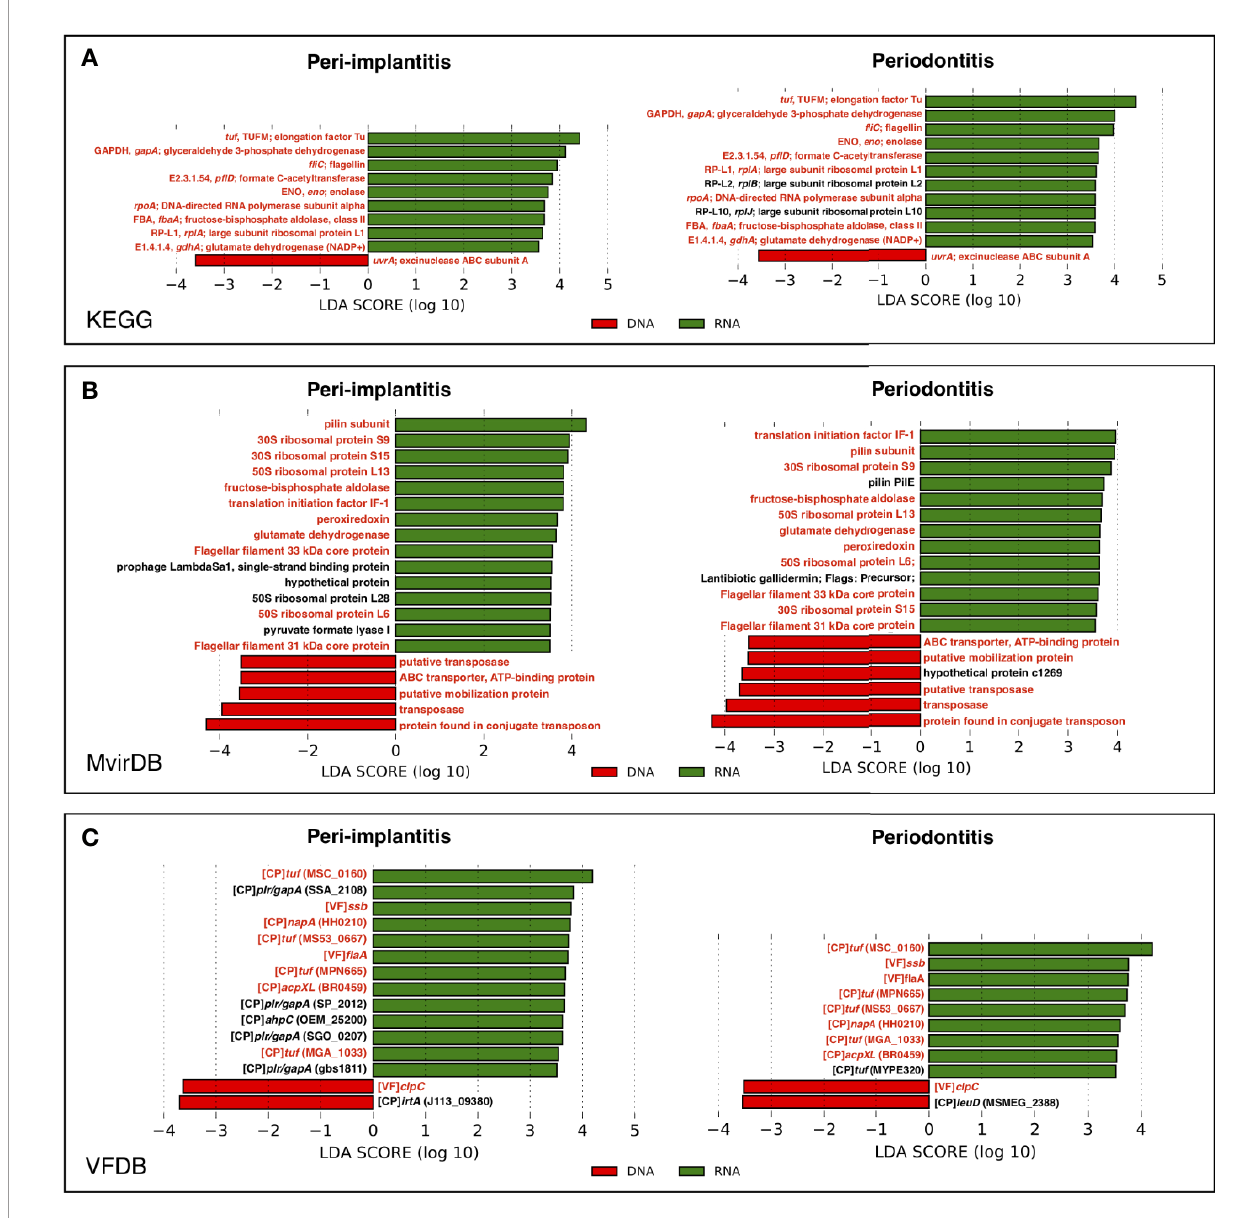
FIGURE 5 | LEfSe analysis comparing peri-implantitis and periodontitis samples based on mRNA indicating enriched genes associated either with the metatranscriptome (green) or metagenome (red). Genes with signi fi cant differences common to both diseases are indicated in red. LEfSe analysis based on (A) KEGG, (B) MvirDB, and (C) VFDB mRNA pro fi le